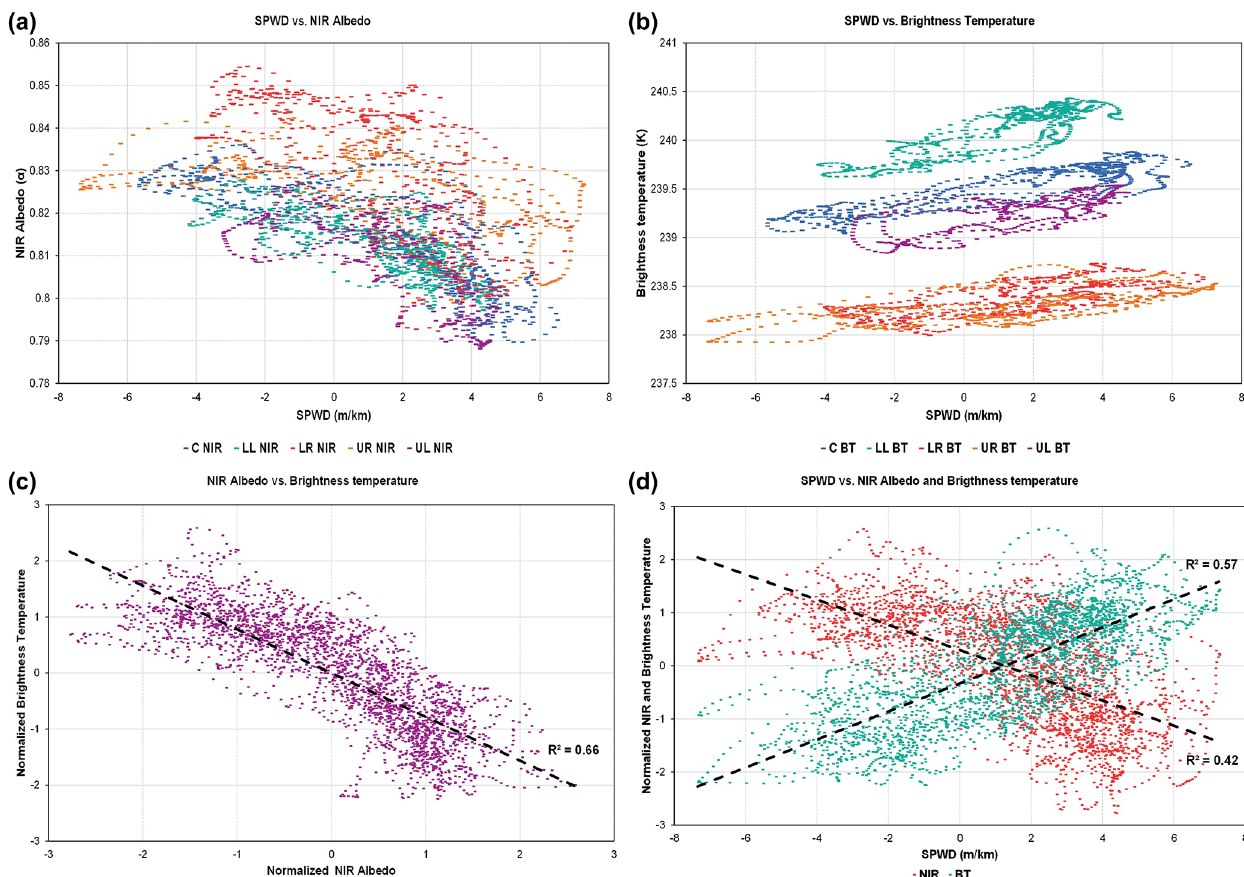
Figure 3. Diagram plots of transects at the EAIIST site from a Landsat 8 image acquired on 25 November 2013: (a) SPWD (slope along the prevailing wind direction) compared within each transect (C, LL, LR, UL, UR; Fig. 1 for location) with NIR spectral albedo and (b) thermal BT; (c) normalized NIR albedo of all transects compared with BT with linear regression; and (d) SPWD compared with normalized NIR albedo and thermal BT for all transects with linear regression. Table 2. Accuracy assessment (%) in the detection of glazed snow using a supervised classification applied on NIR, BT and SPWD and their combination over the four scenes of the 2013–2014 summer season and on 17 December 2015. The results of BT and SPWD (alone) are not reported, as they present the same result in all cases (i.e. 0% for BT and 30% for SPWD).